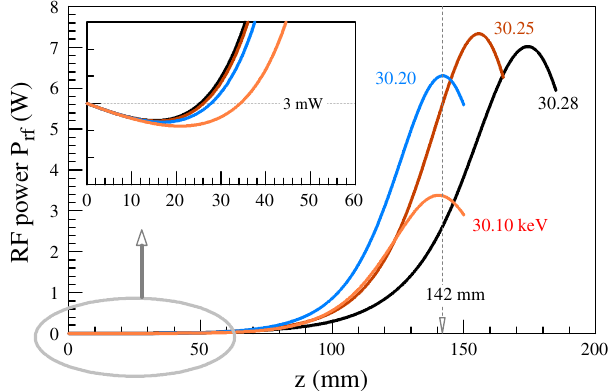
FIG. 9. (Color) (Given rf frequency). The rf power profiles for different beam energies. Beam current: 25 mA; initial axial i (cid:3) 0 : 46% ); focusing mag- velocity spread: 7 : 5 (cid:10) 10 (cid:4) 4 ( (cid:2) V= h V 0 netic field: 4 kG; input rf power: 3 mW at 220 GHz. For a 142-